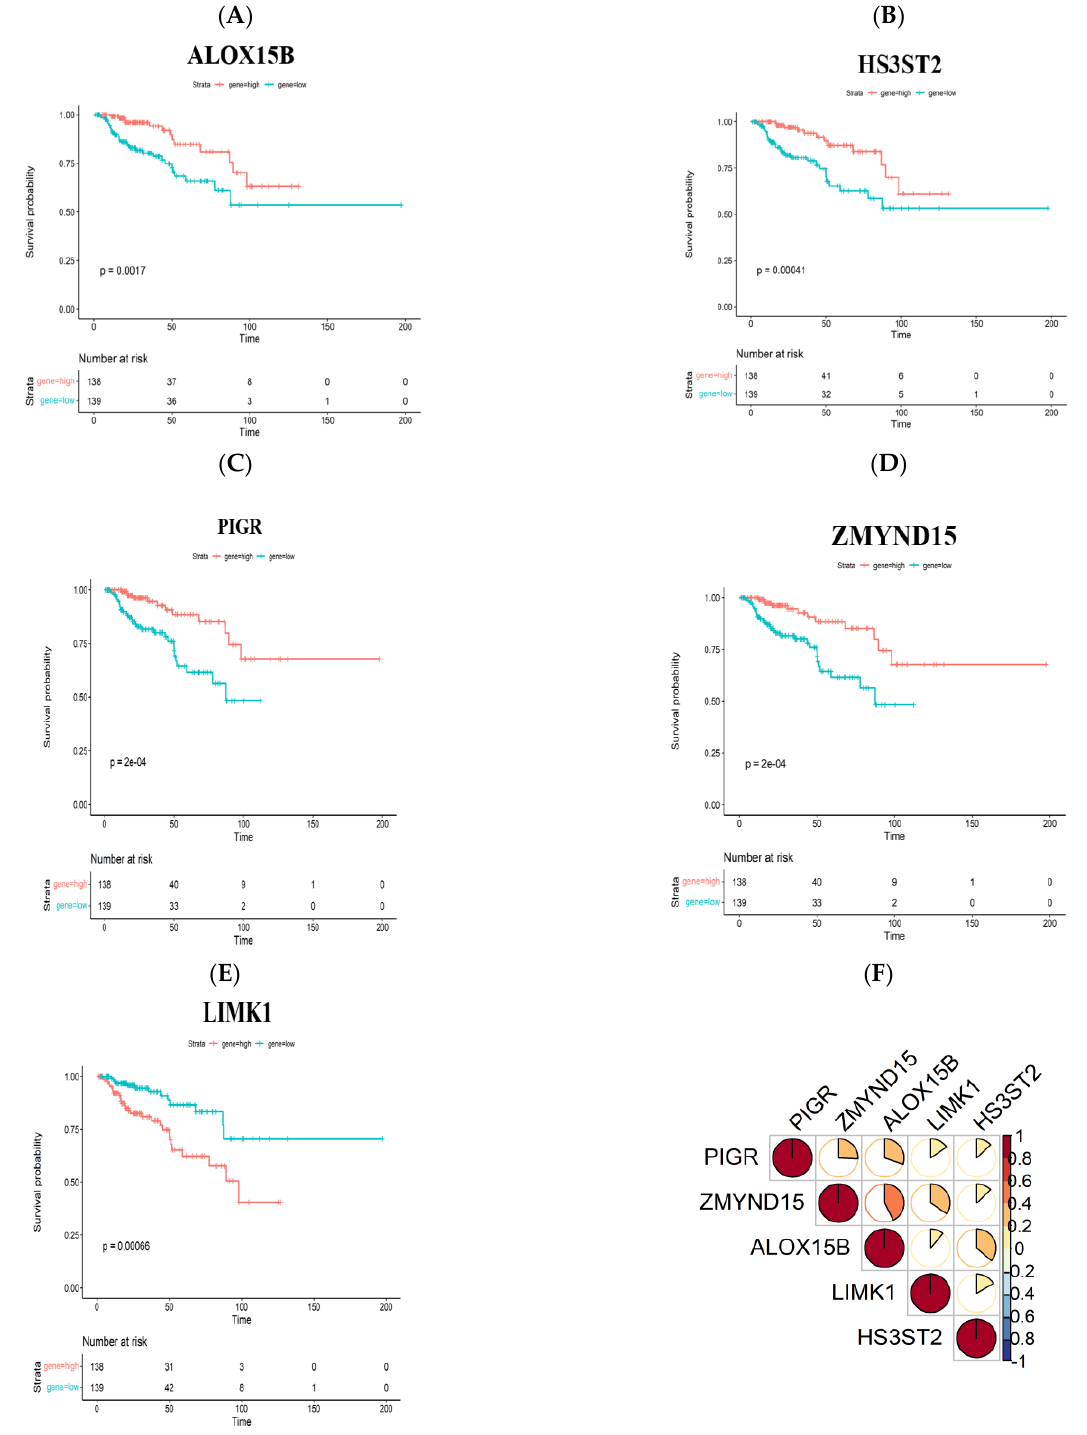
Figure 3. The associations between five potential PRCC antigens and three types of APCs. ( A ) The number of separate and common genes among mutated, upregulated and survival-related groups. ( B ) Pie chart from Funrich [32] revealing the major biological processes these common genes partic- ipate in. ( C )The expression associations between intersected genes and APCs based on the ssGSEA method. ( D – H ) The expression correlations between ALOX15B ( D ), HS3ST2 ( E ), PIGR ( F ), ZMYND15 ( G ), LIMK1 ( H ) and infiltration degrees of APCs were quantified with the TIMER database.